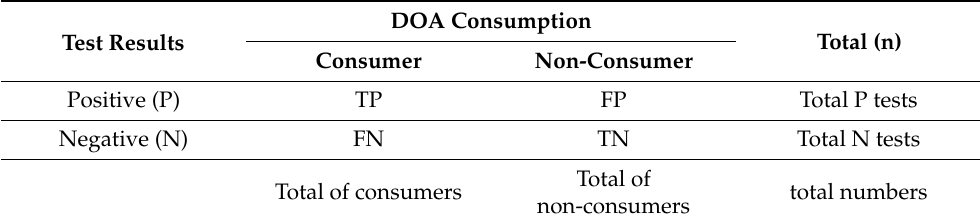
Table 1. Probable results for each test (lateral flow immunoassay, LFIA). Test